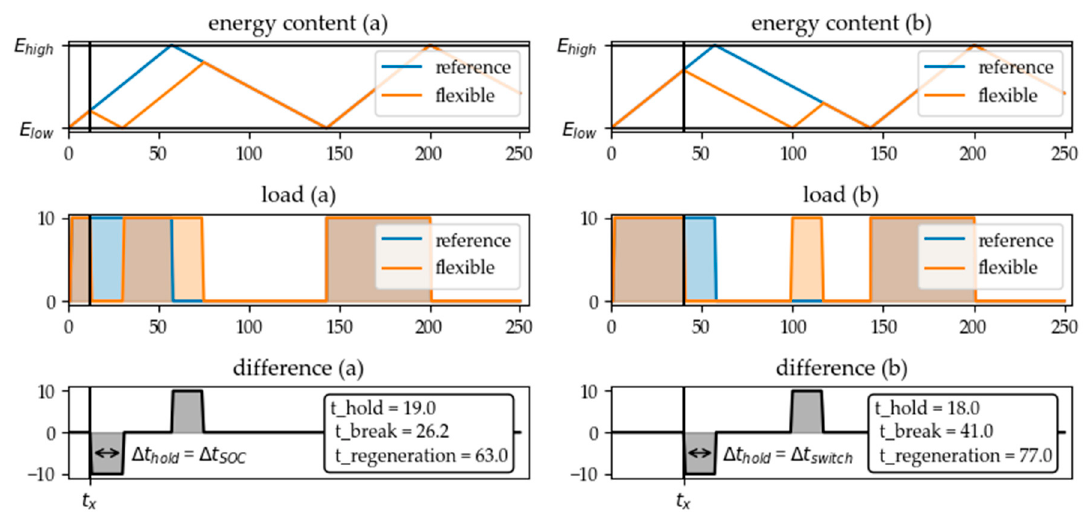
Figure 9. Two parameters can limit the holding time of the flexibility measure: The time interval ∆ t SOC in which the limit of energy content of the storage is reached in flexible operation mode ( a ) or the time until the next switching time in reference mode is reached ∆ t switch ( b ).